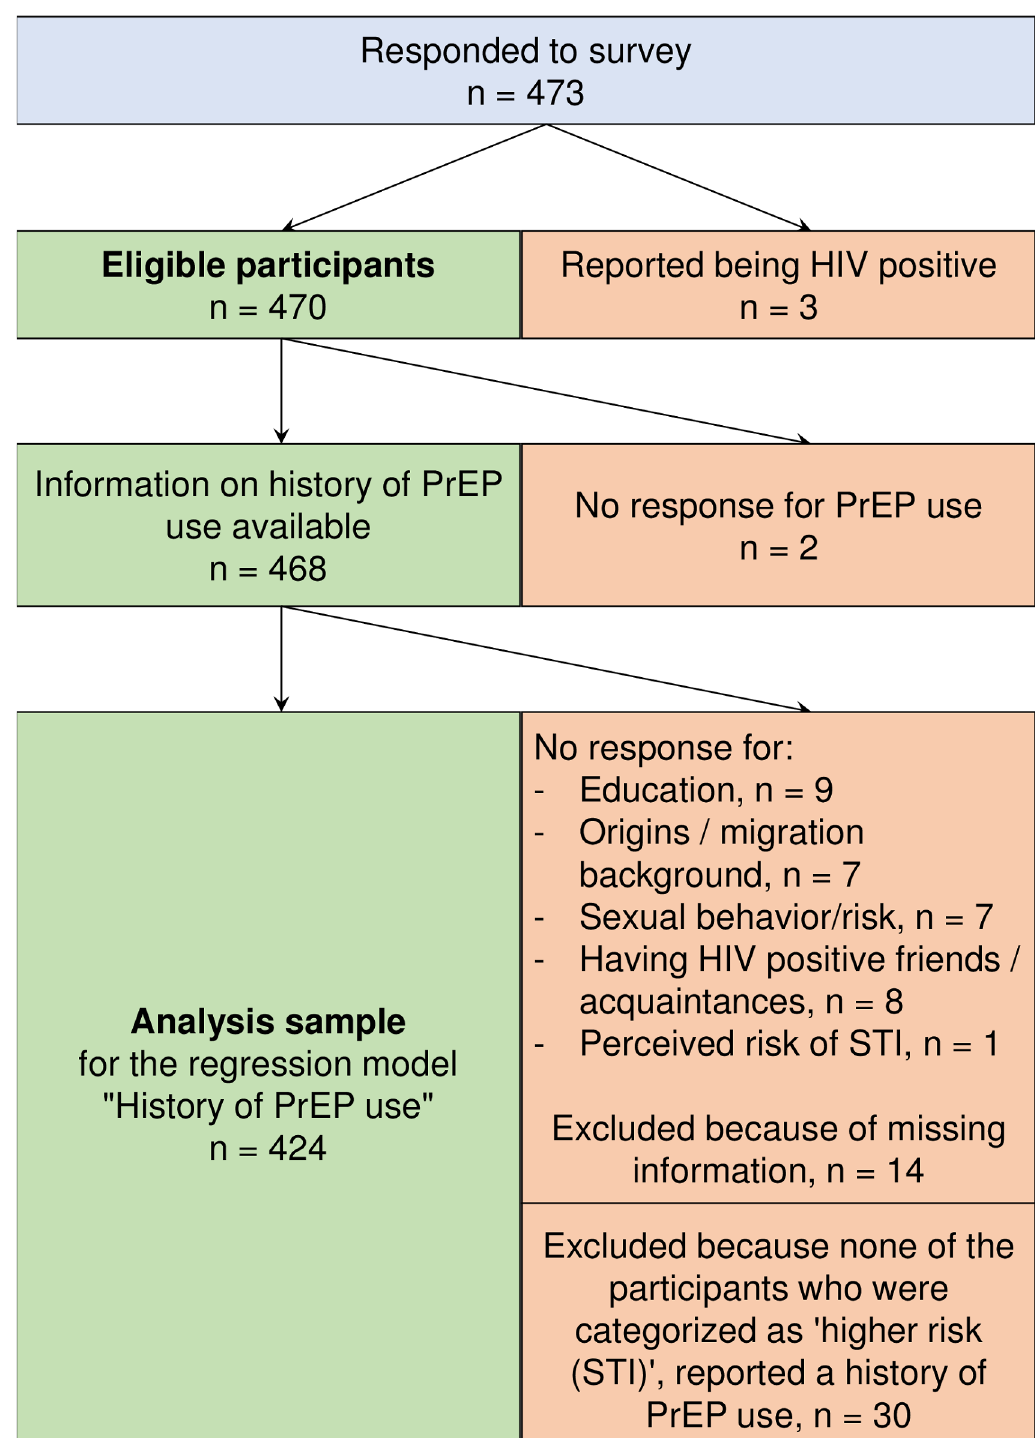
Fig 2. Response tree for the multivariable regression model for history of PrEP use.